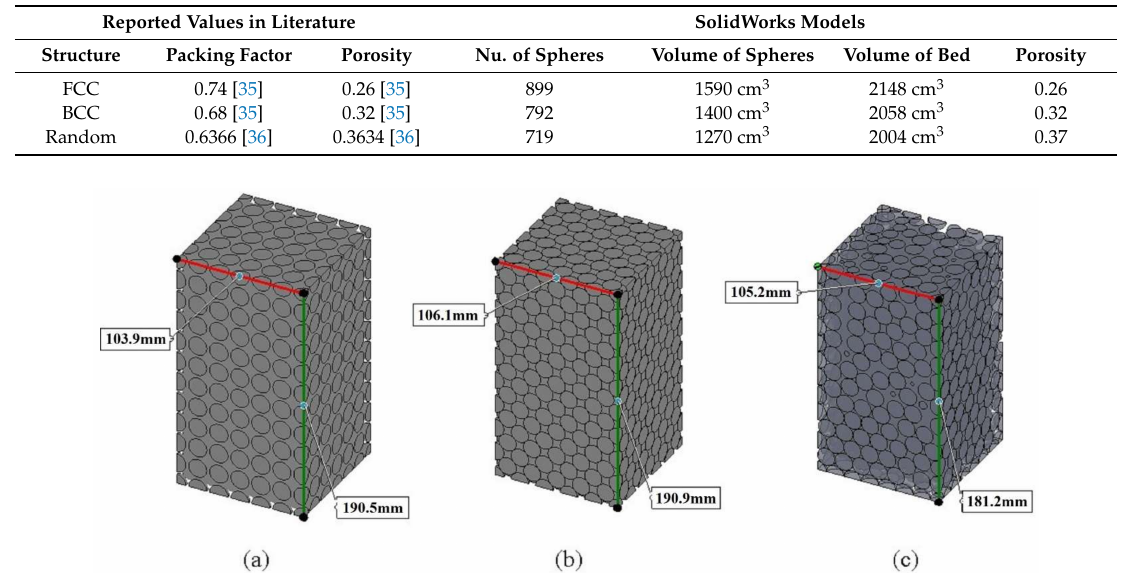
Table 3. Porosities of three bed structures.